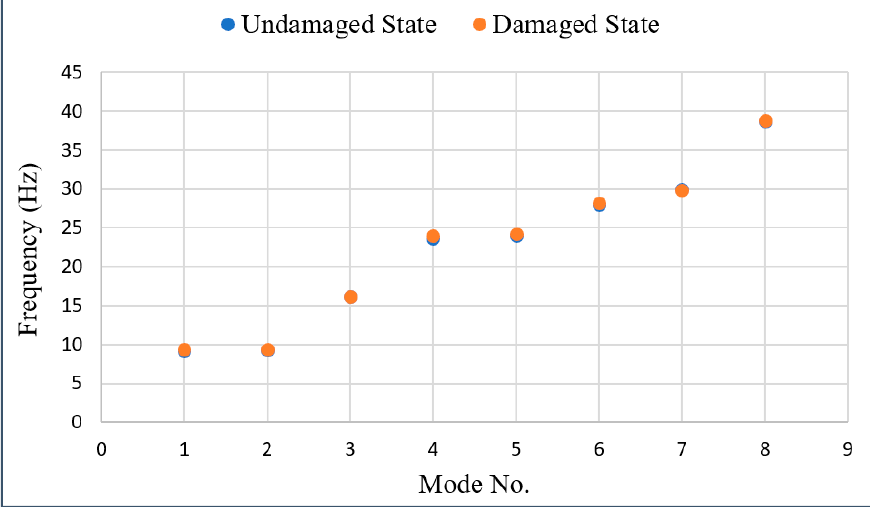
Figure 15. Natural frequencies in modes for both undamaged and damaged states of the Hannam 2 Overpass.